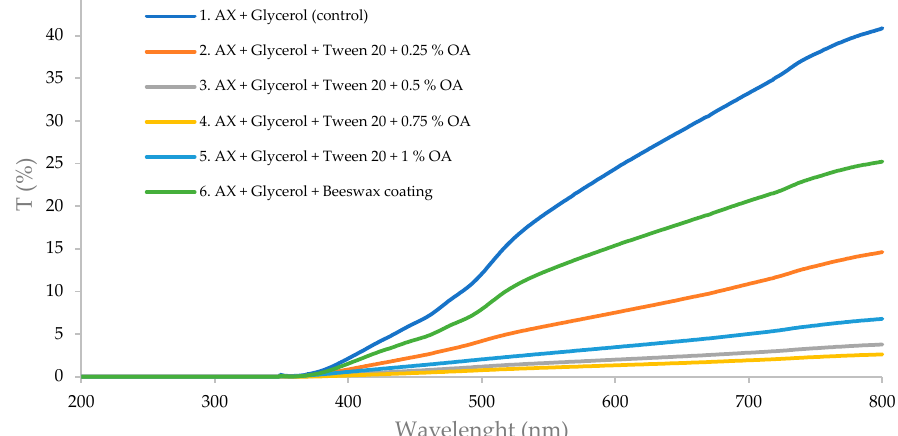
Figure 2. Transmittance (T, %) in the ultraviolet-visible spectrum, ranging from 200 nm up to 800 nm, of all film samples.